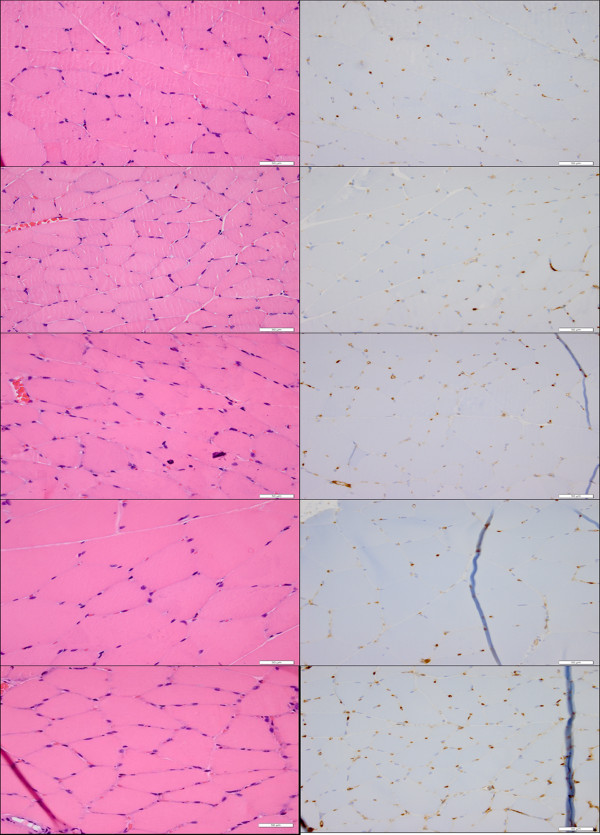
Acute histology (H&E—left, CD31—right) demonstrating the lack of tissue level effects associated with US-UCA exposure for various [UCA] at 40× magnification. Top to bottom: medial-site control, saline (0x [UCA]), 1× [UCA], 5× [UCA], 10× [UCA]. Bar = 50 μm. Arrows show capillary engorgement.